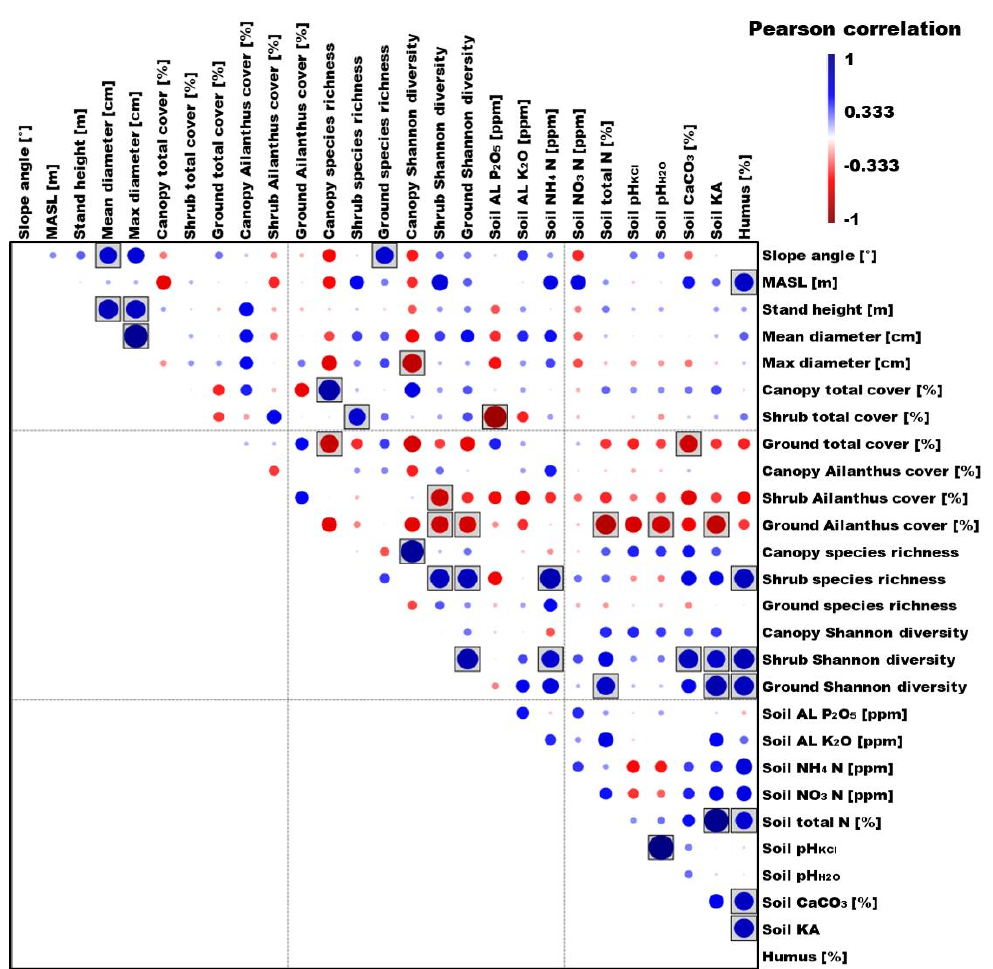
Figure 5. Linear (Pearson) correlation of the examined biotic and abiotic factors: blue—circle size proportionally scaled; red—positive correlation; boxed—negative correlation; p < 0.005 significance.